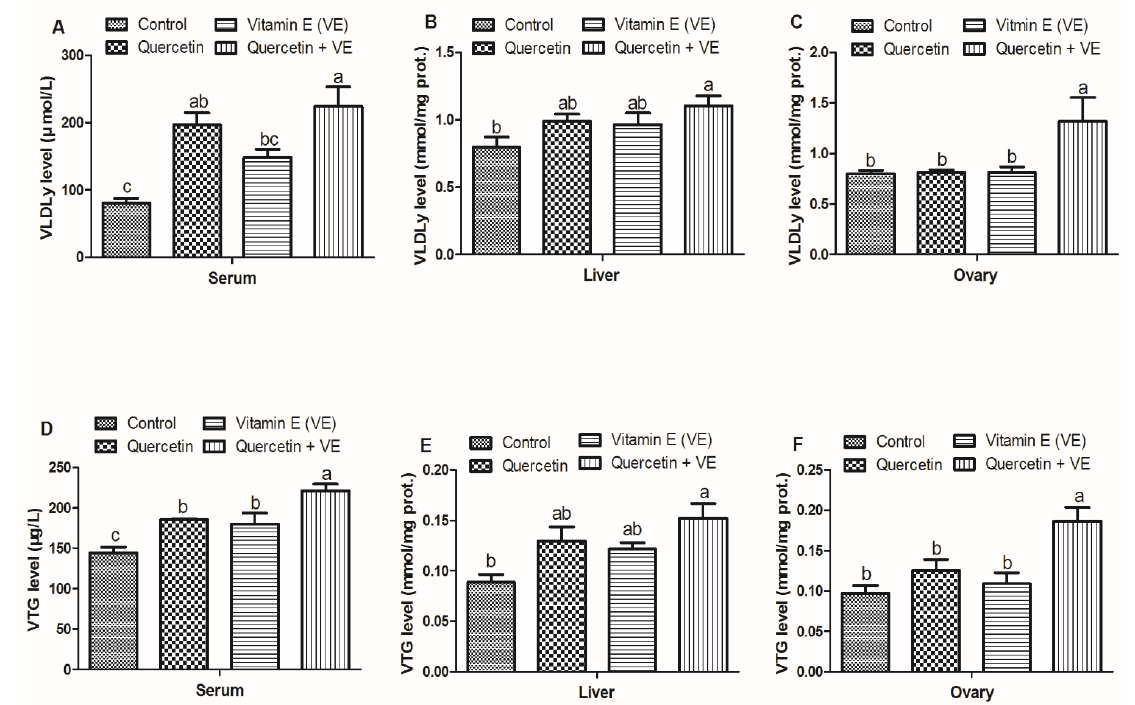
Figure 3. Effects of quercetin, vitamin E, and quercetin + vitamin E on the very low density lipoprotein (VLDLy) and vitellogenin (VTG) levels in the liver, serum, and ovary of the aging breeder hens. prot: protein. Levels of VLDLy ( A – C ) and VTG ( D – F ). The values are presented as the mean ± SD. Bars without the same letter differed significantly ( p < 0.05). prot: protein.